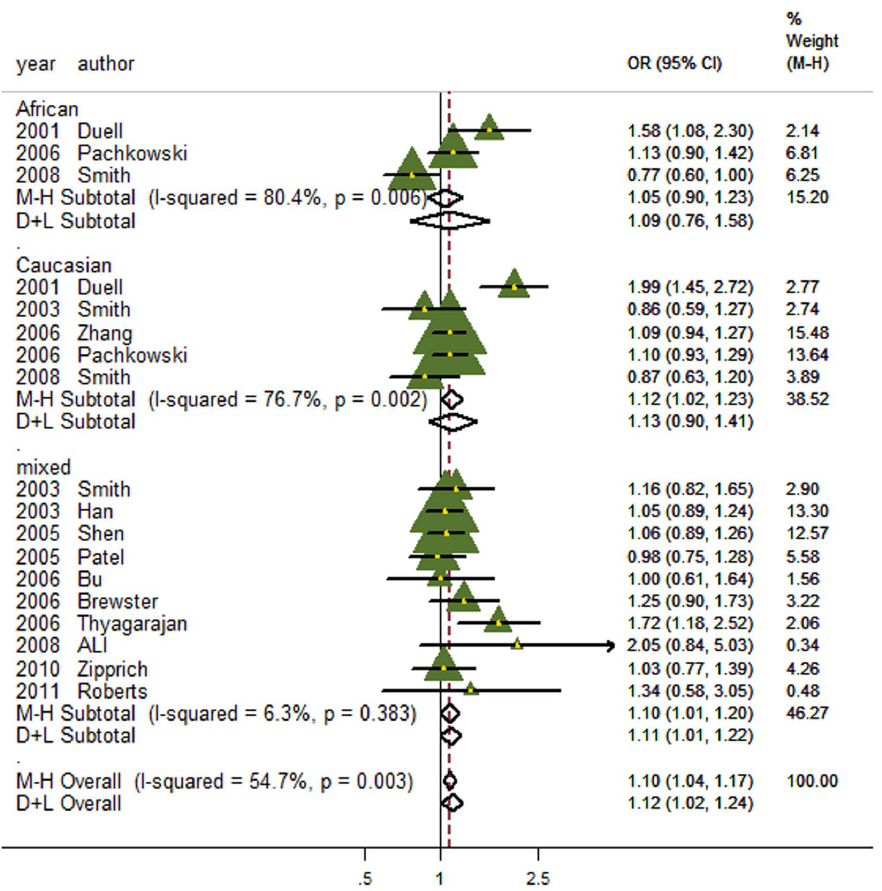
Figure 2. Forest plot of the association between the XRCC1 Arg399Gln and breast cancer risk for the dominant model.